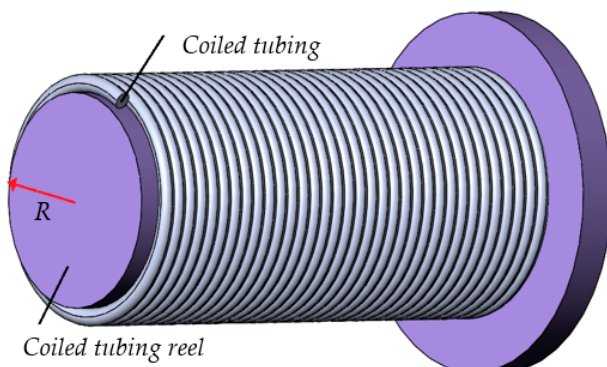
Figure 1. Schematic diagram of one-layer CT.